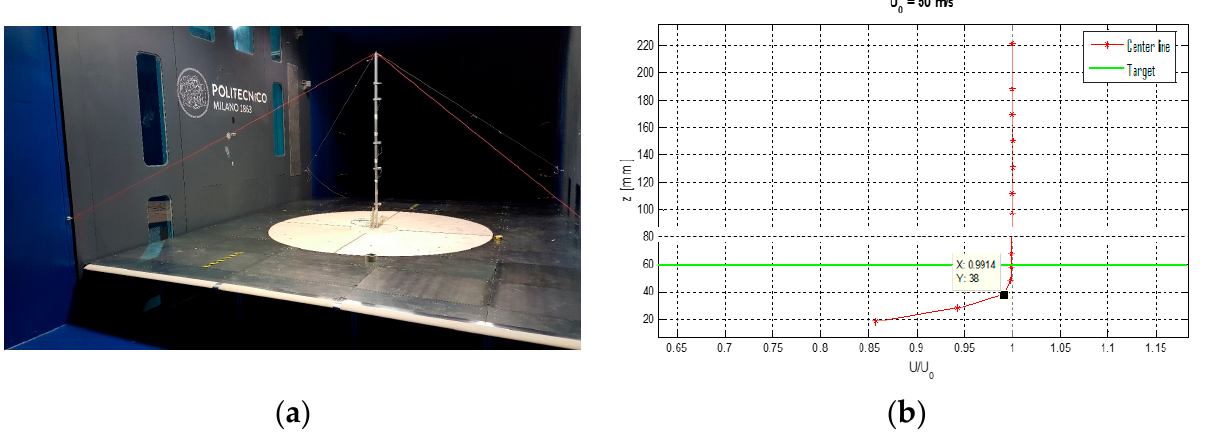
Figure 1. Splitter plate of GVPM wind tunnel: ( a ) Splitter plate mounted on the test section; ( b ) vertical profile of the mean wind speed measured over the splitter plate.